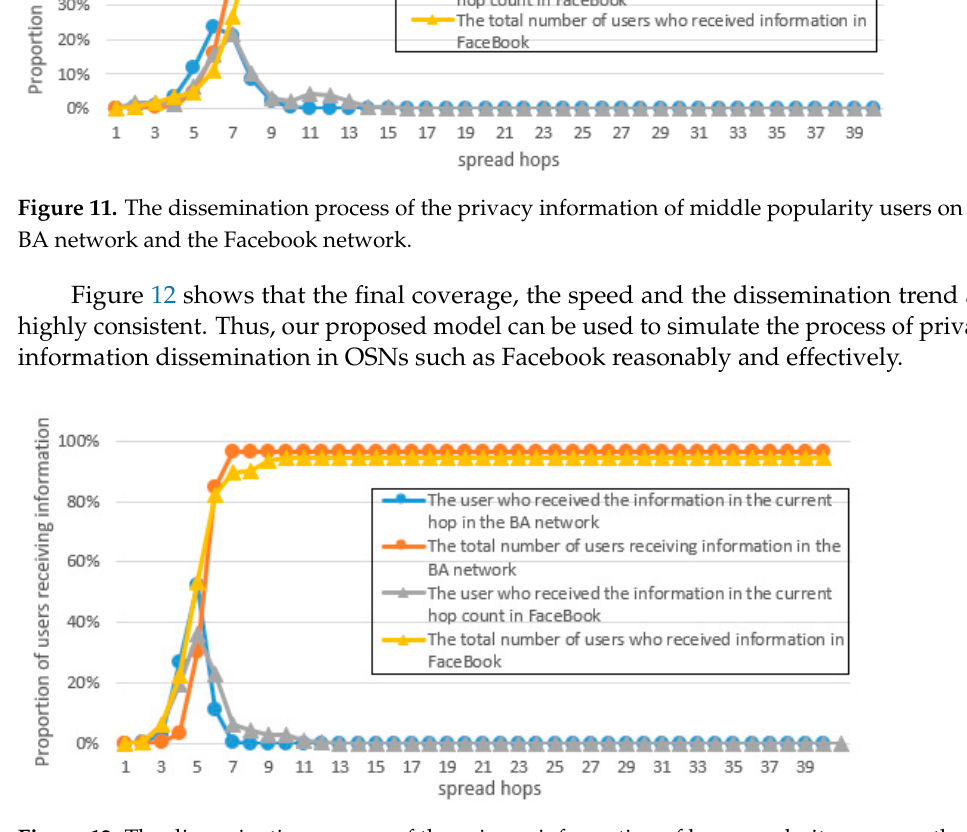
Figure 12. The dissemination process of the privacy information of low popularity users on the BA network and the Facebook